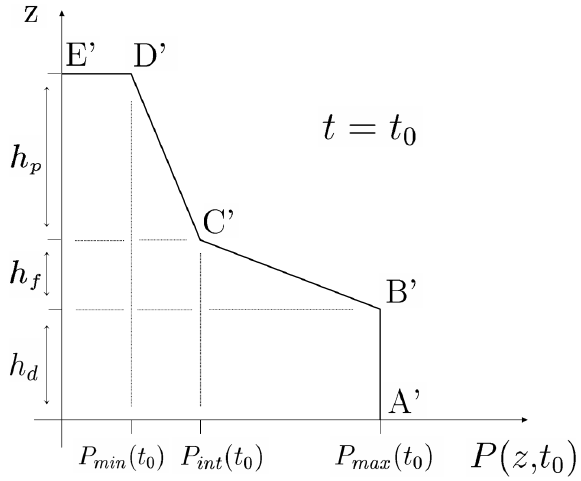
Fig. 4. Pressure distribution over flow thickness at time t 0 .